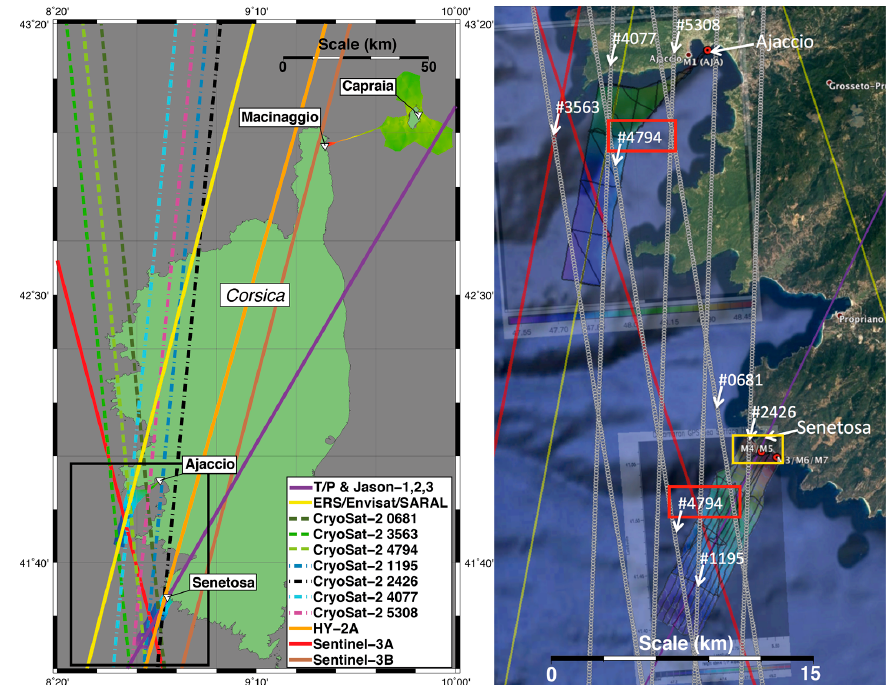
Figure 1. Left : General configuration of the Corsica calibration site with all of the satellite altimeter missions ground tracks that have been monitored since 1998 (the black frame on the left bottom corresponds to the zoom on the right map). Right : zoom on Ajaccio and Senetosa sites with Sentinel-3A (red) and CryoSat-2 (grey) tracks. The red rectangles highlight the CryoSat-2 pass #4794 that crosses the Senetosa and Ajaccio sites (see Section 0). The yellow rectangle shows the area that is discussed in Section 0 for pass #2426 (see Figure 8c).